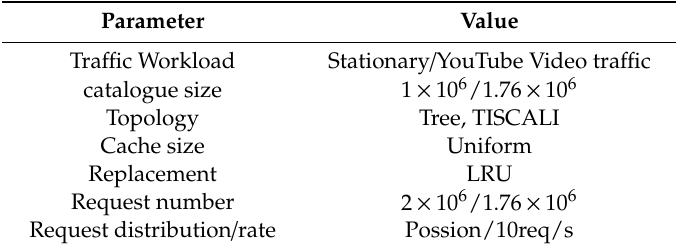
Table 1. Simulator environment. LRU: least recently